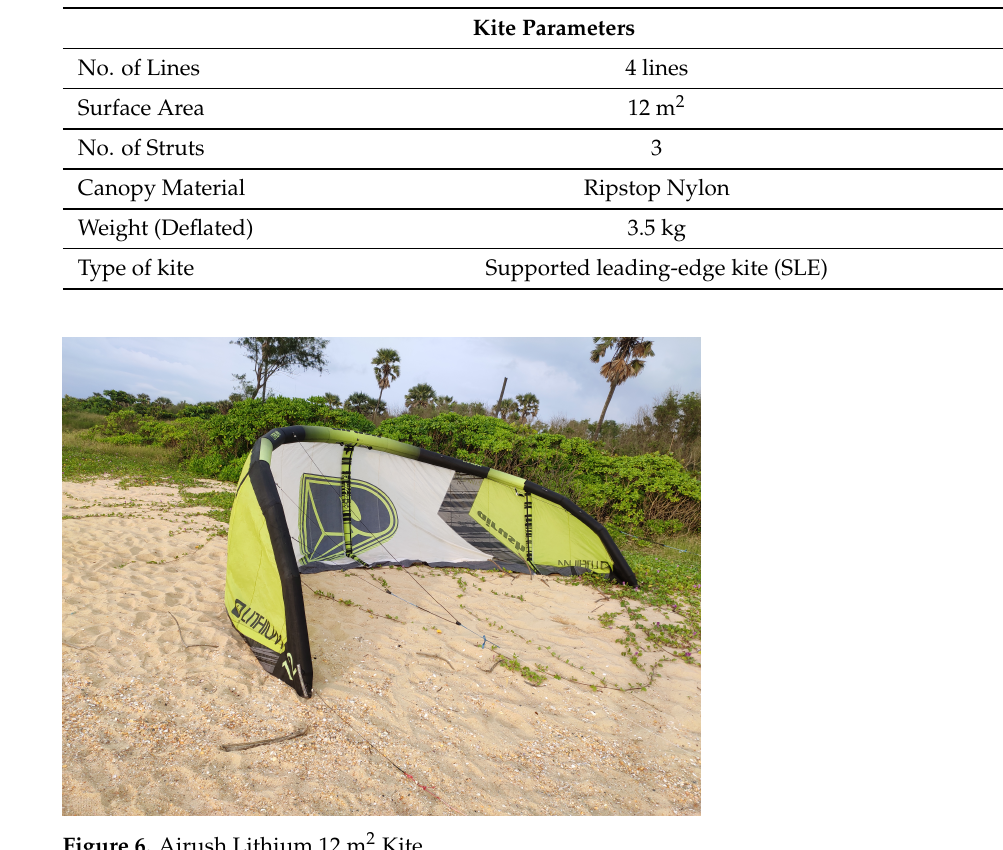
Figure 6. Airush Lithium 12 m 2 Kite.